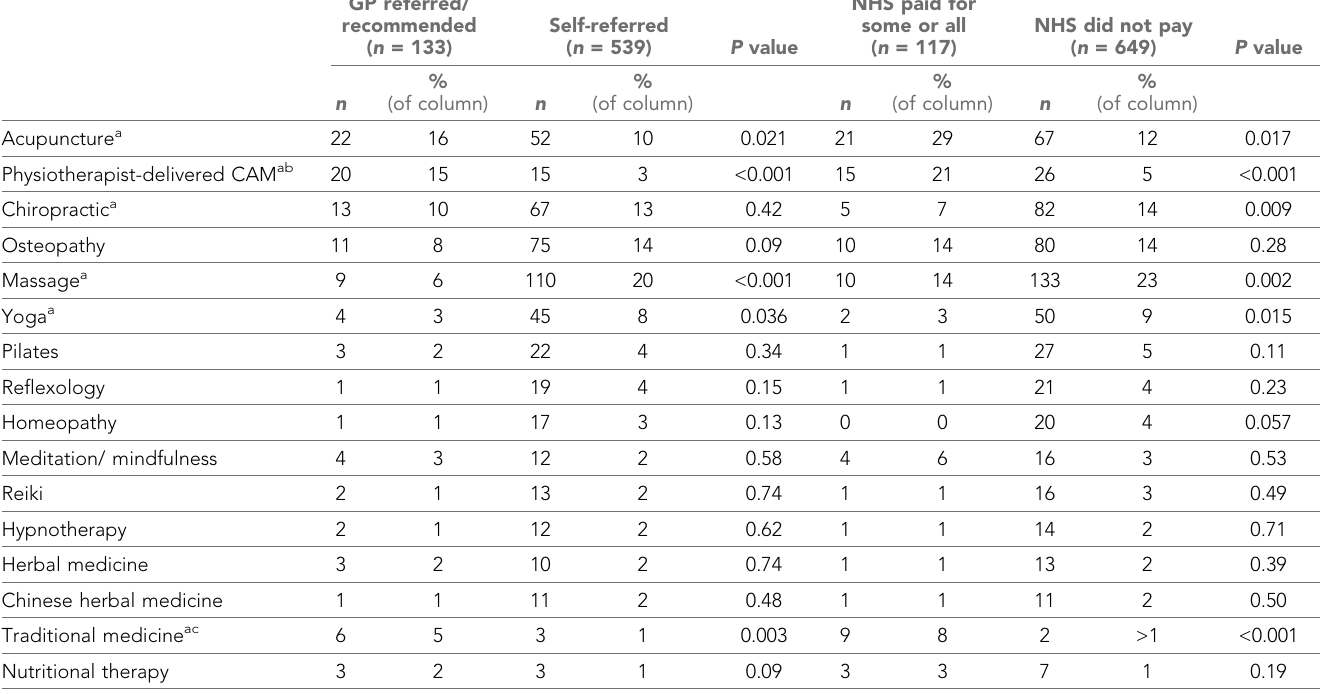
Table 5 Pathways to and payment for practitioners offering 16 most popular CAM